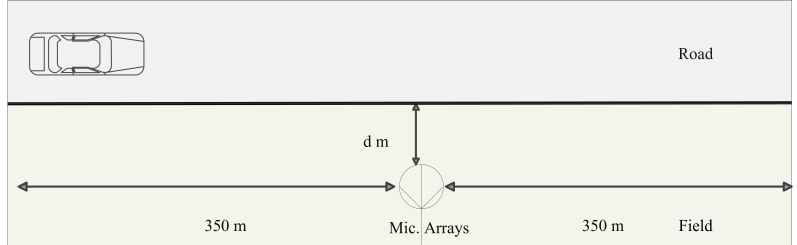
Figure 2. The system hardware circuits layout.